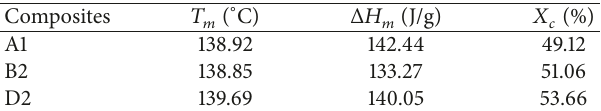
Table 4: Summary of DSC data of composites types A1, B2, and D2.